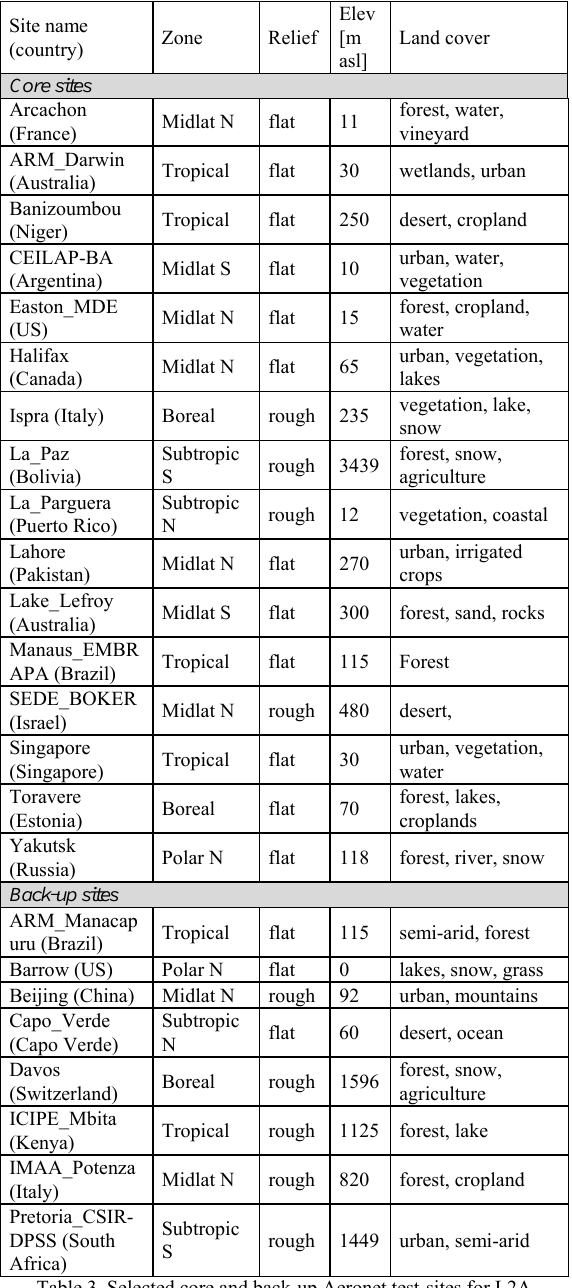
Table 3. Selected core and back-up Aeronet test-sites for L2A